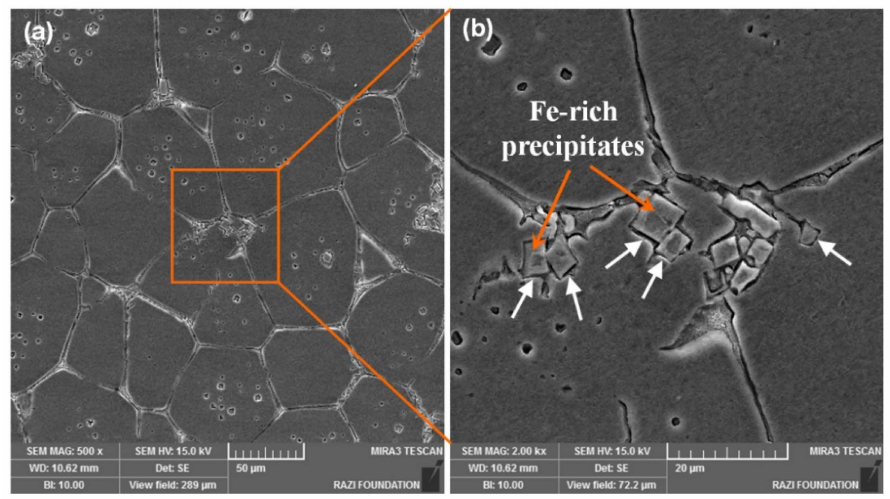
Figure 14. ( a ) SEM image of a strained sample heat treated at 600 ˝ C for 15 min; ( b ) SEM image of selected area in (a).